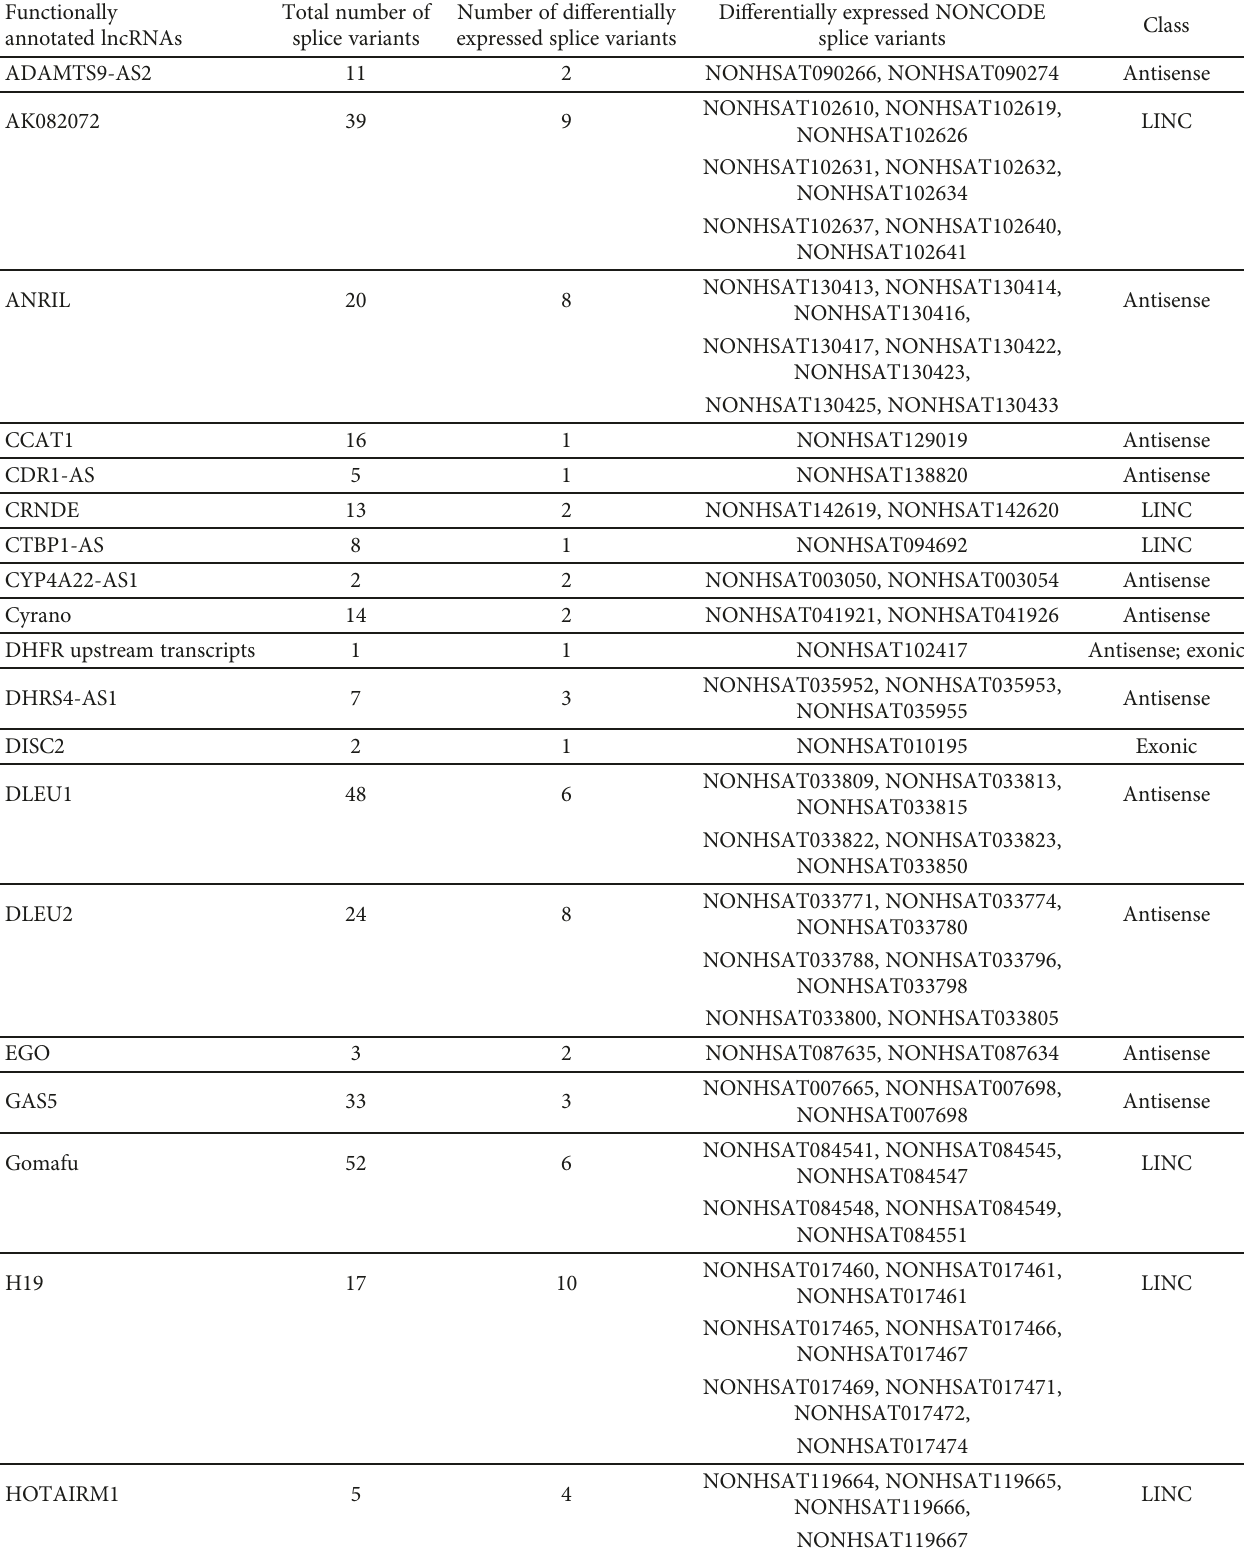
Table 2: Di ff erentially expressed splice variants of functionally annotated lncRNAs from HMECs following LPS treatment for 3 and 24